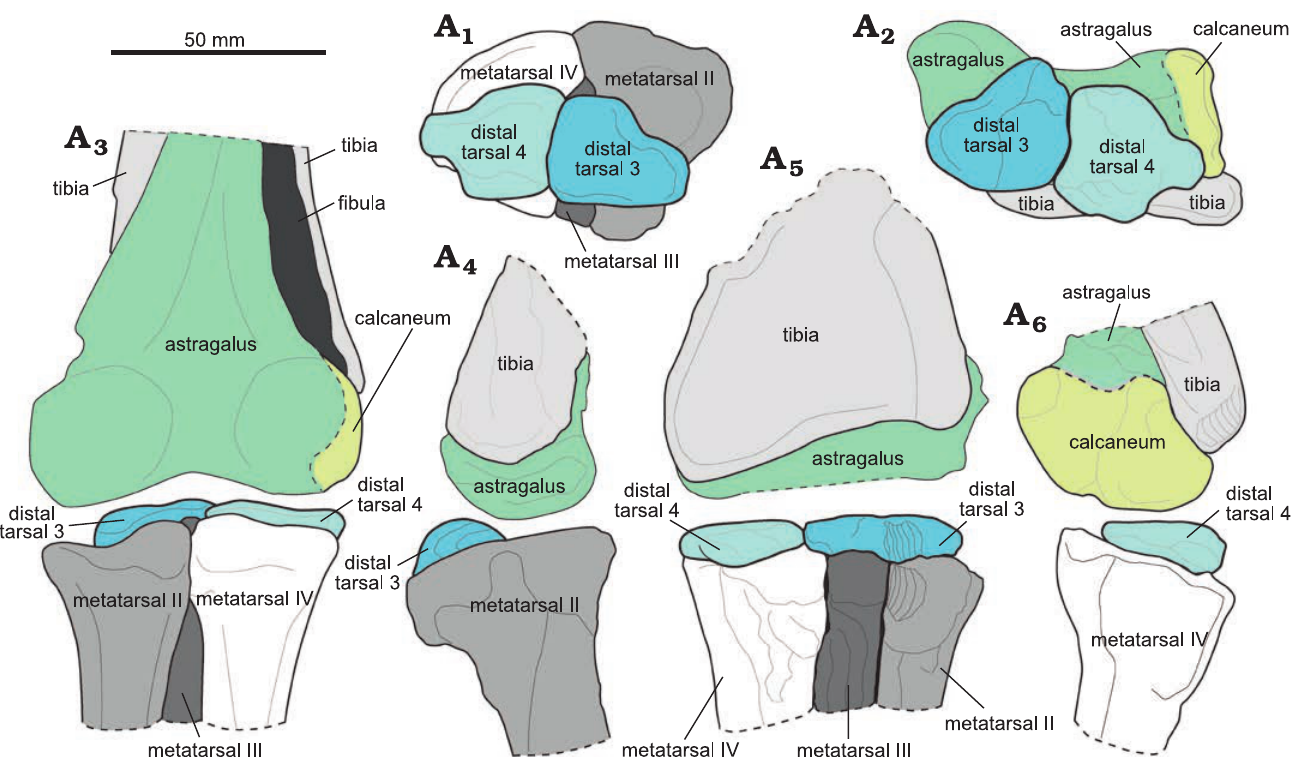
Fig. 2. Reconstruction of left tarsal region of Ornithomimidae indet., RAM 6794 from upper Campanian Kaiparowits Formation, Utah, USA. Proximal view within tarsal joint (A 1 ), distal view within tarsal joint (A 2 ), anterior (A 3 ), medial (A 4 ), posterior (A 5 ), and lateral (A 6 ) views. Artwork by Hannah Caisse